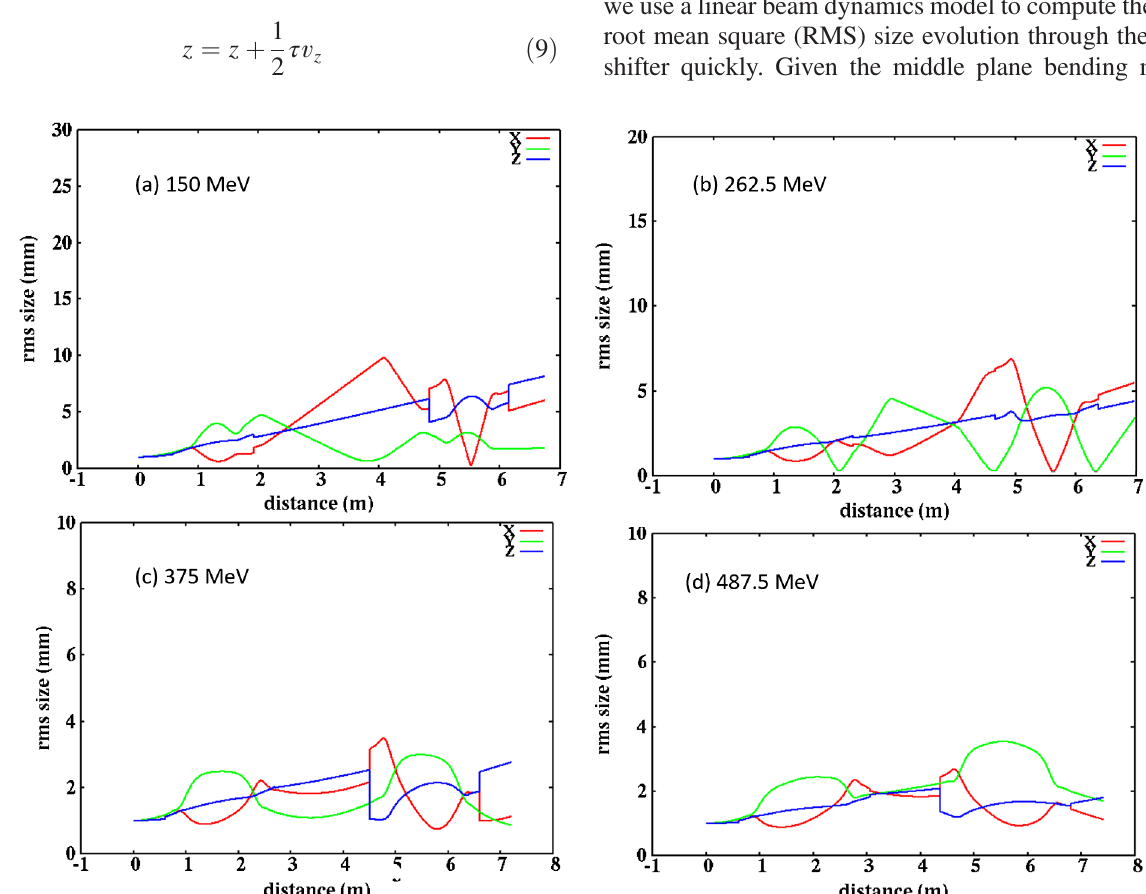
FIG. 5. Proton beam transverse and longitudinal RMS size evolution through the phase shifter (Table I) with 150 MeV (top left), 262.5 MeV (top right), 375 MeV (bottom left), 487.5 MeV (bottom right) kinetic energy, initial Waterbag distribution, and zero